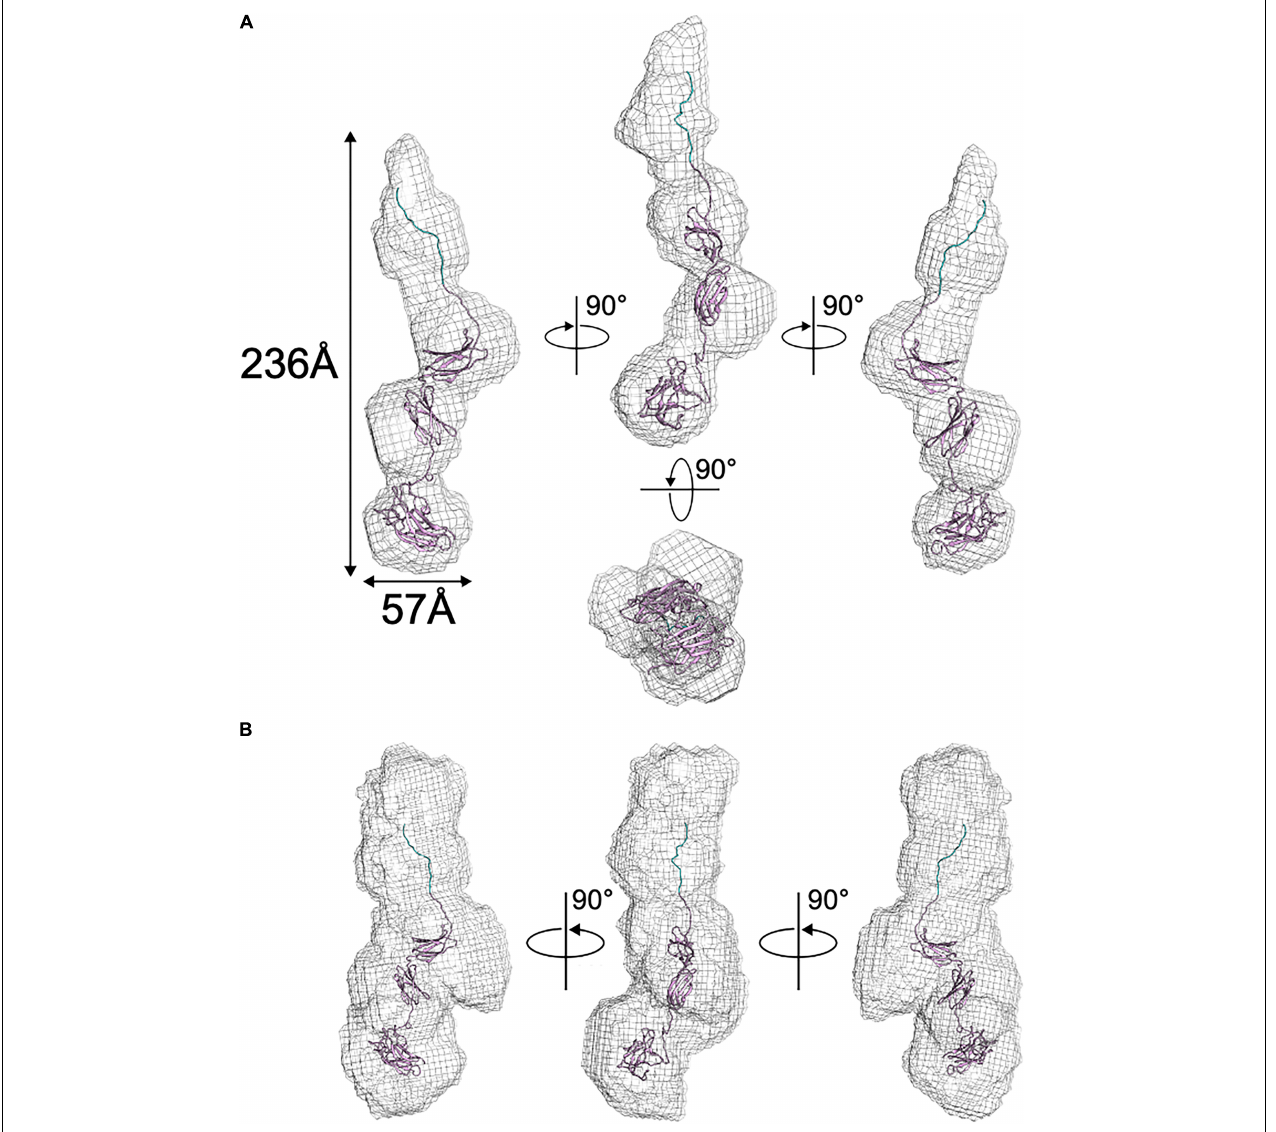
FIGURE 5 | Solution structure of BT2857 as determined by DAMAVER. (A) Ab initio resolved protein envelope (shown as gray mesh) with fitted BT2857 homology model informed by the structure of BT3158 (shown in ribbons). (B) BT2857 contains an N-terminal histidine-tag region (section of ribbon colored